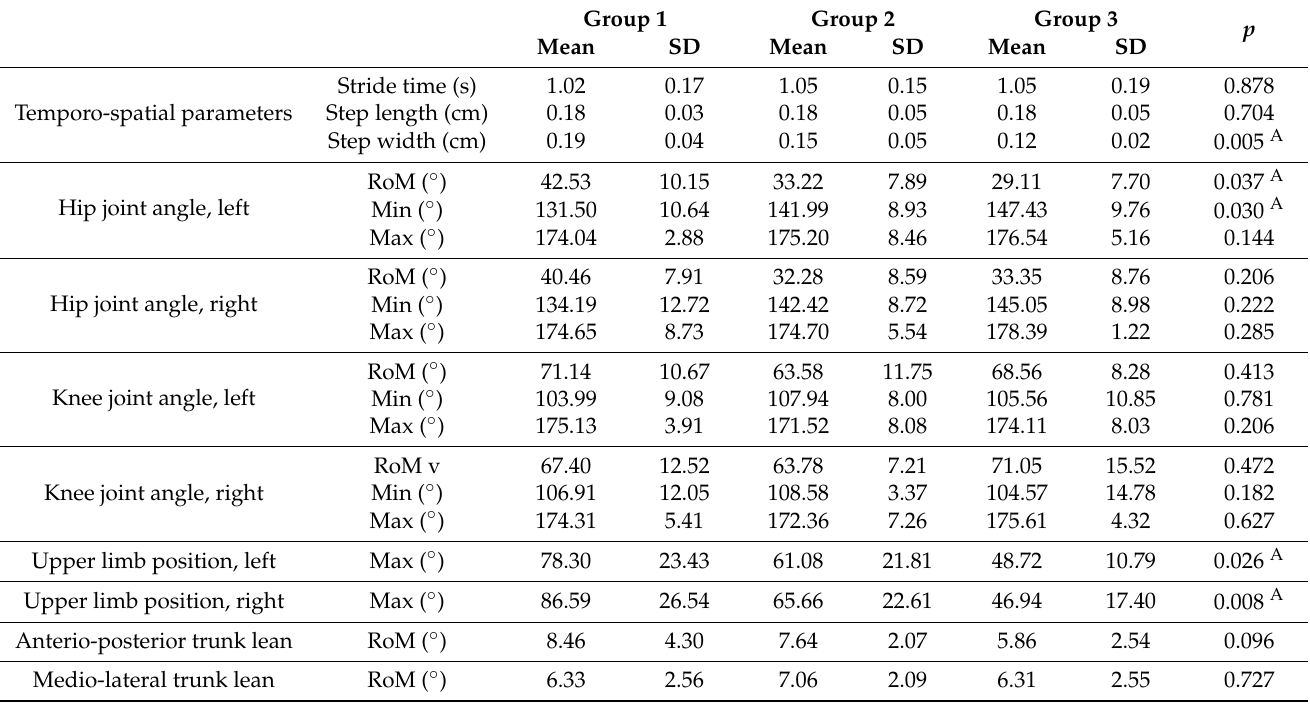
Table 2. Mean and SD of analysed parameters for Groups 1, 2, and